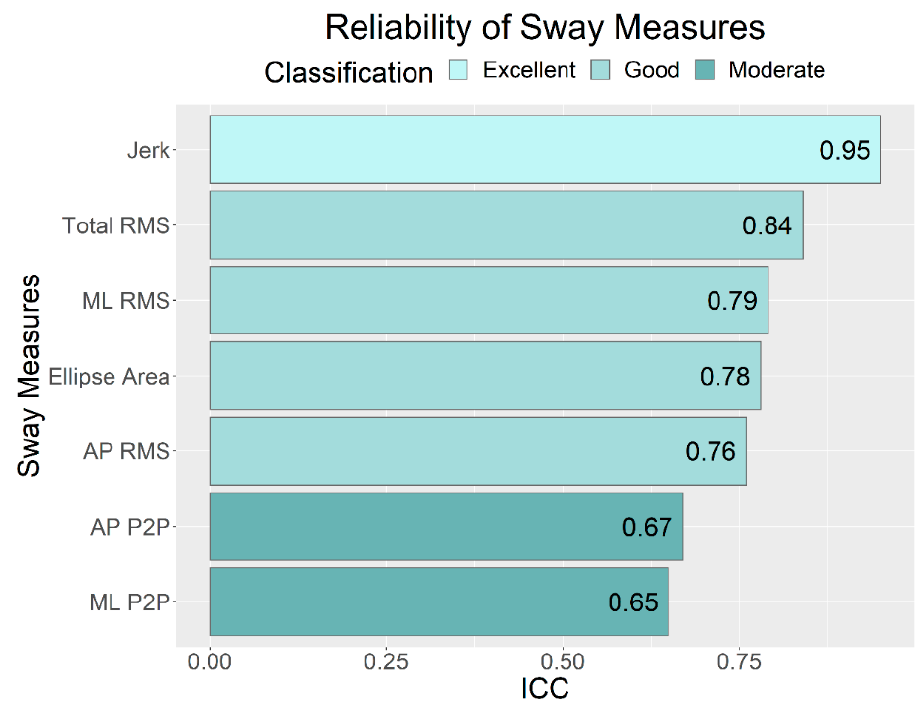
Figure A1. Visual representation of the reliability for each sway metric.